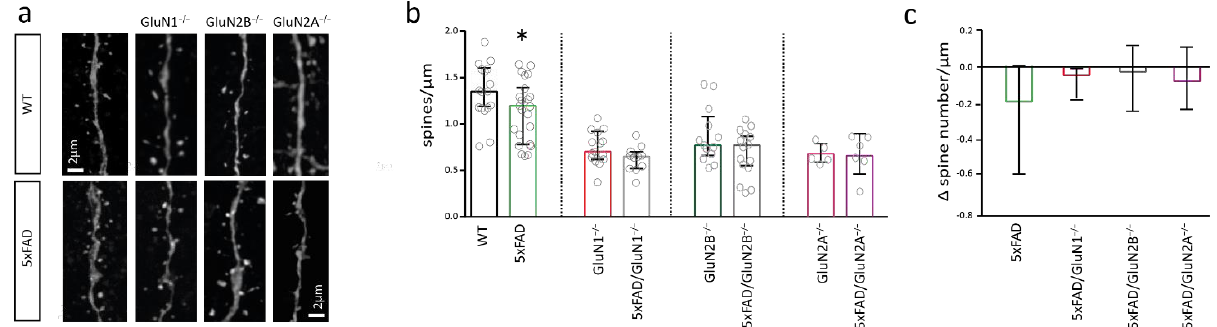
Figure 3. Loss of dendritic spines in 5xFAD mice depends on NMDARs. ( a ) Sample images of dendrites containing spines of pyramidal cells of the somatosensory cortex of wildtype (WT) and 5xFAD mice with and without deletion of GluN1, GluN2B, and GluN2A. ( b ) Bar graph showing the number of spines per µm in neurons of WT ( n = 17) and 5xFAD ( n = 23) mice (left), in neurons with GluN1 deletion (middle left) ( n = 15 GluN1 −/− vs. n = 10 5xFAD/GluN1 −/− ), GluN2B deletion (middle right) ( n = 13 GluN2B −/− vs. n = 15 5xFAD/GluN2B −/− ) or GluN2A deletion (right) ( n = 5 GluN2A −/− vs. n = 6 5xFAD/GluN2A −/− ). ( c ) Bar graph showing the Δ spine number/µm in pyramidal cells from 5xFAD mice when compared to the respective control mouse (WT, GluN1 −/− , GluN2B −/− , GluN2A −/− ), quantified from data in ( b ). Data in bar graphs are shown as median ± interquartile range. Empty grey circles depict a single data point. t -test: * p < 0.05.